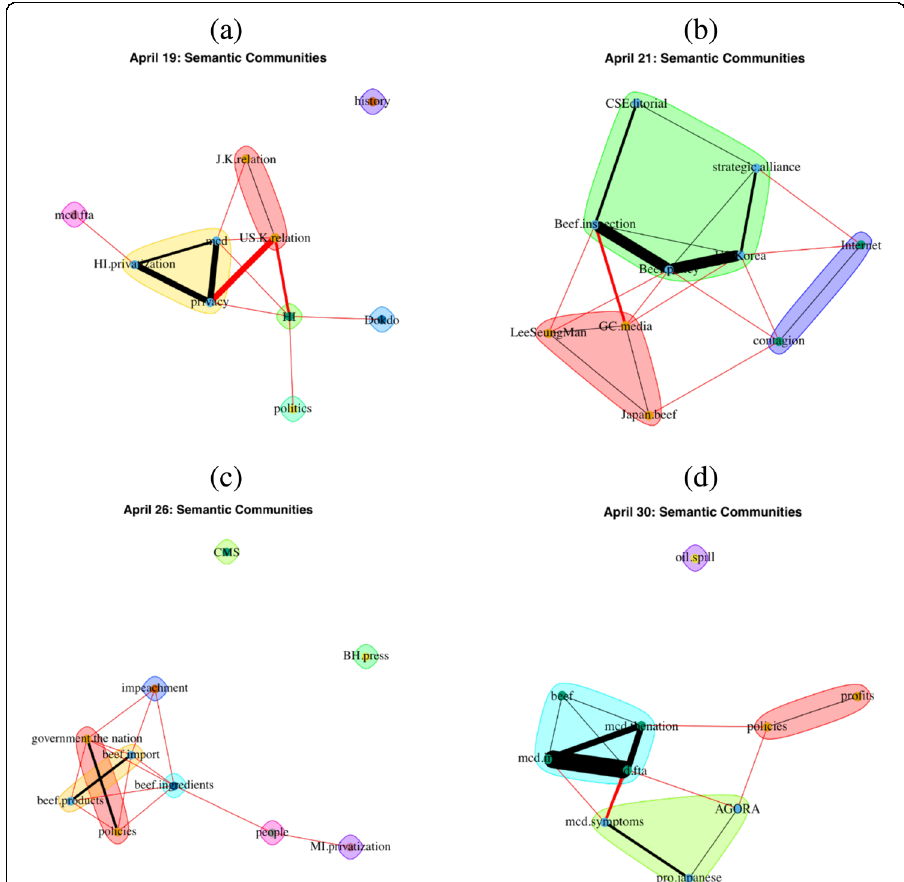
Fig. 3 Note: Low modularity in topic networks. Note : These four networks of topics all mark modularity scores below 0.2. Red and black lines present respectively links within community and inter-community. Topic networks with low modularity tends to have inter-community ties that are more developed than intra-community